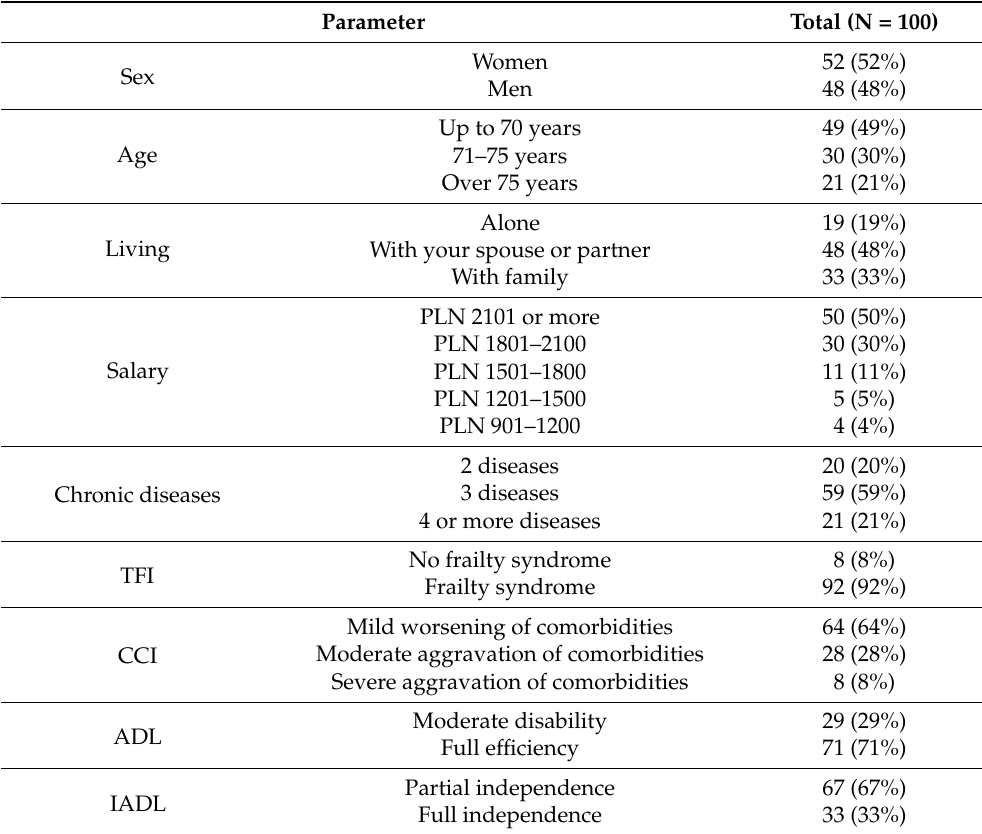
Table 1. Socio-demographic and clinical characteristics of the study